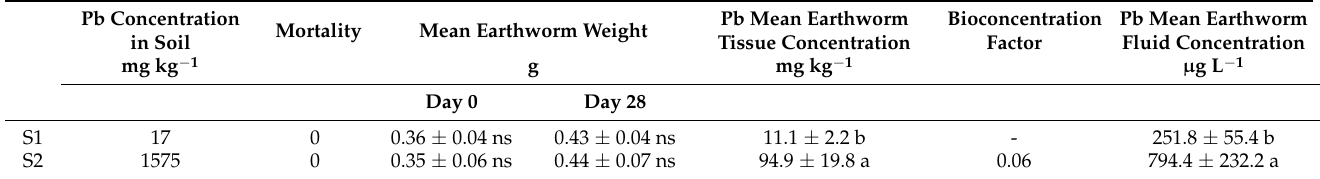
Table 2. Results of bioassays with E. andrei in the unpolluted (S1) and polluted (S2) soils. Ecotoxicol- ogy data (mean value ± standard deviation, n = 5) with different letters in the column are statistically different according to t -testing ( p <